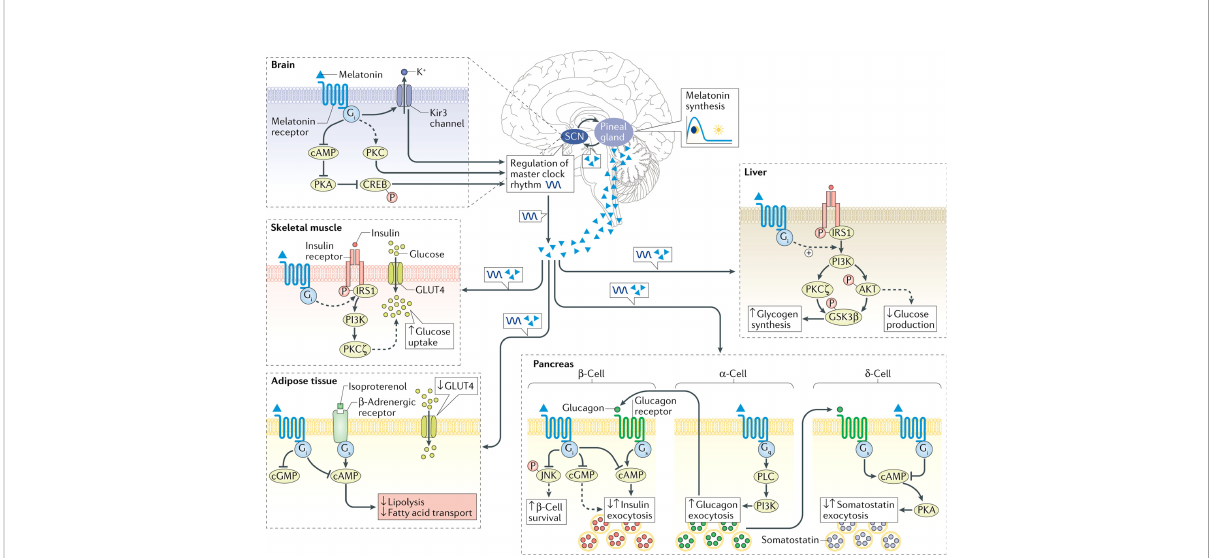
FIGURE 1 Metabolic processes in fl uenced by melatonin signaling in peripheral and central tissues. Broken lines correspond to the function of melatonin, which exact pathways remain to be elucidated. The dark blue wave-formed line illustrates the circadian clock oscillation. Reprinted by